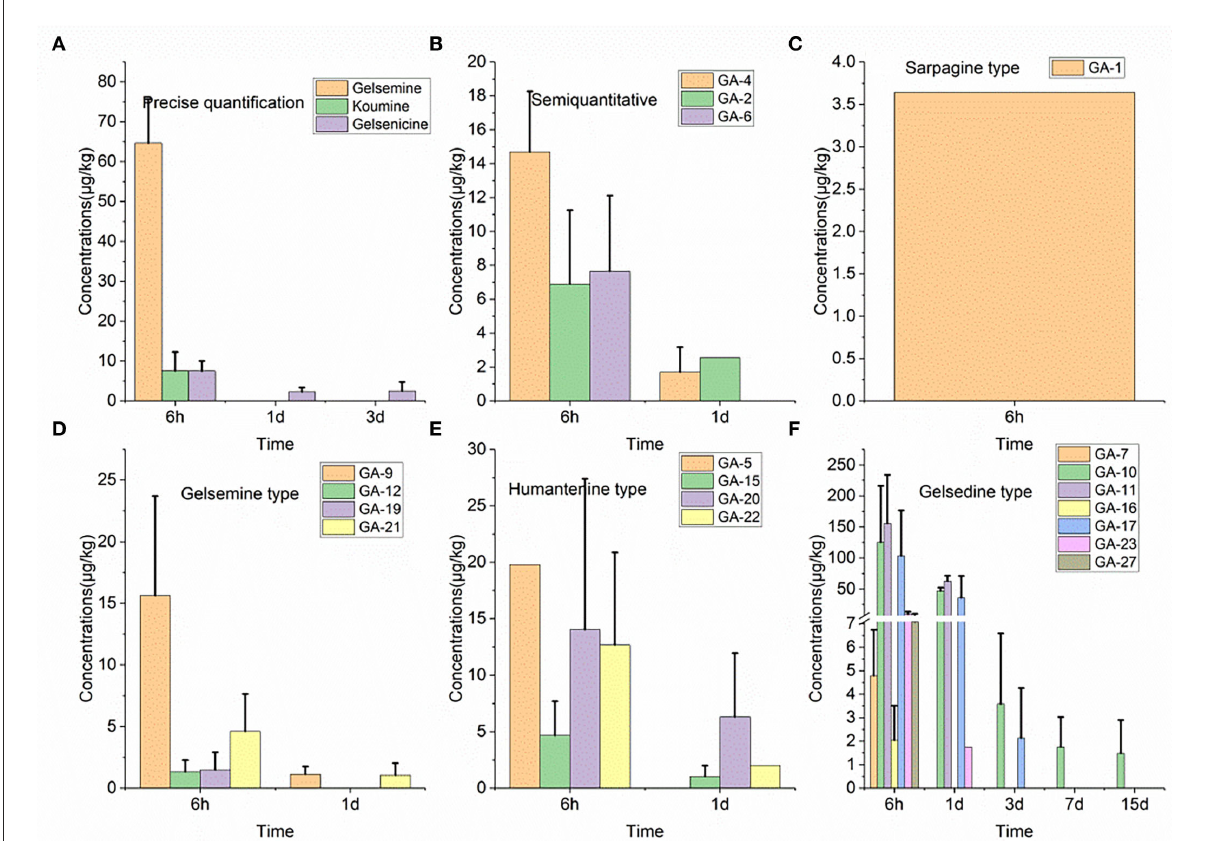
FIGURE2 (A–F) Depletion of Gelsemium alkaloids in pig pancreas after 45 d of consecutive administered G. elegans powder at a dose of 2% per kilogram